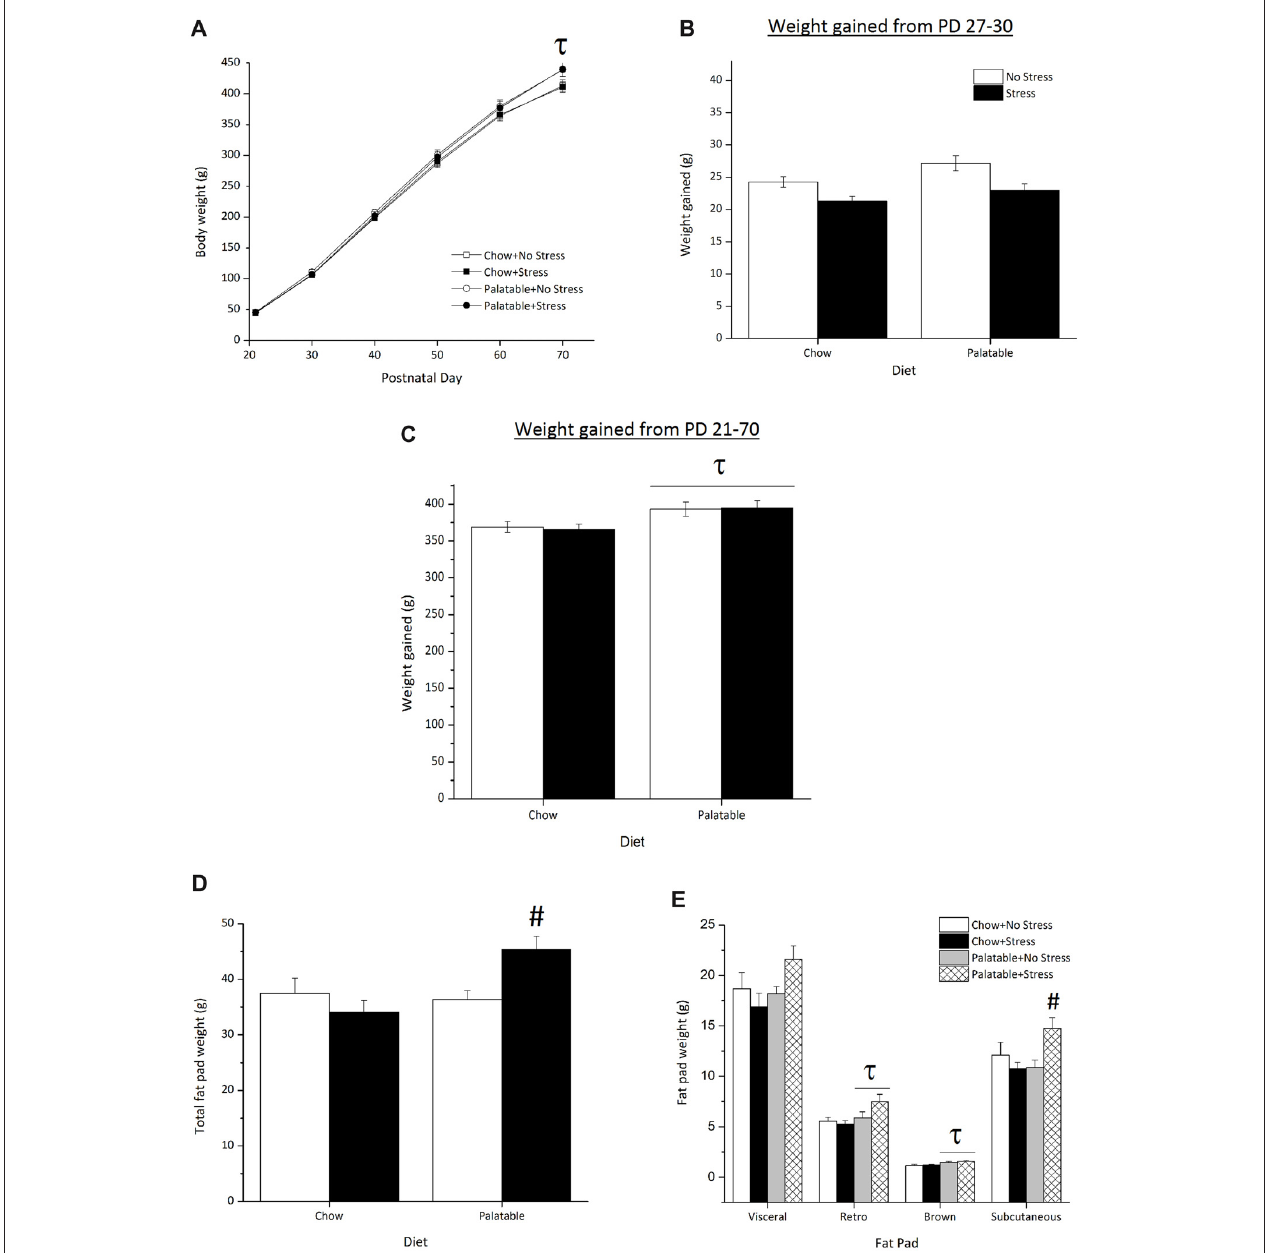
FIGURE 3 | Effect of access to a palatable diet and juvenile stressor exposure on body weight and adiposity. (A) Consumption of a palatable diet led to greater body weight on PD 70. (B) There were no significant differences in weight gained from PD 27–30 shortly after juvenile stressor exposure (C) Access to the palatable diet increased overall weight gained from PD 21–70. (D) Access to a palatable diet increased total adiposity in juvenile stressed rats only. (E) Access to a palatable diet and juvenile stressor exposure increased subcutaneous fat, whereas access to a palatable diet increased retroperitoneal and brown fat. τ Significantly different to chow diet groups ( p < 0.05). # Significantly different from other conditions ( p < 0.05).